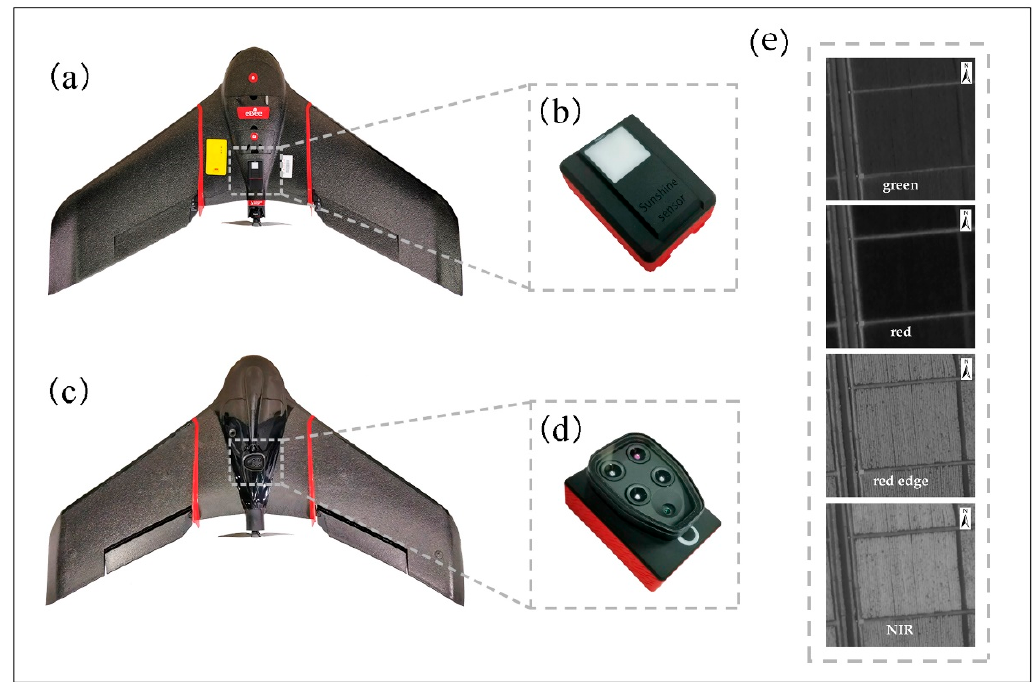
Figure 2. Unmanned aerial vehicle (UAV) platform (eBee SQ) and sensors used in this study: ( a ) Front of the UAV; ( b ) sunshine sensor; ( c ) back of the UAV; ( d ) multispectral camera; ( e ) truncated images of four magnified orthomosaic images generated at the stem elongation stage.